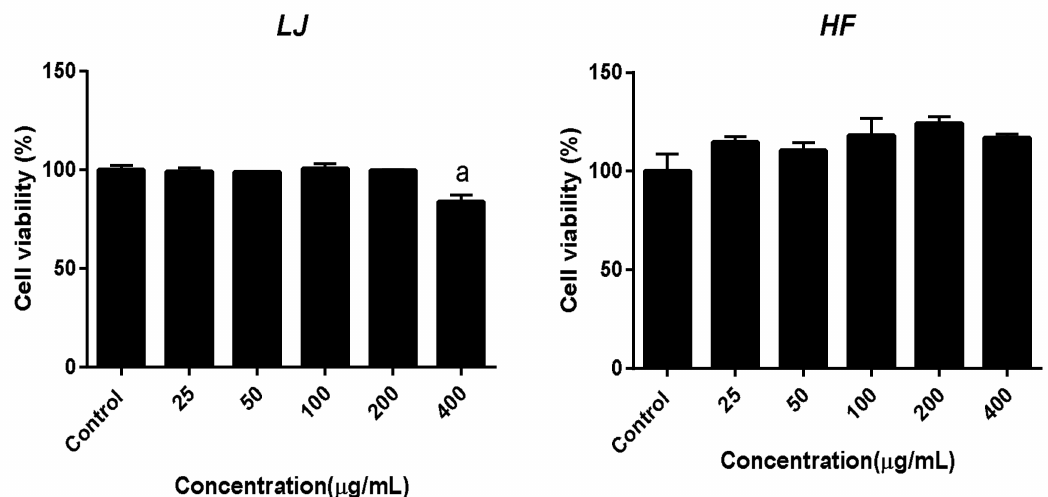
Figure 2. Effects of LJ and HF extracts on cell viability in C2C12 muscle cells. Data are represented as add the mean ± SEM of three independent experiments. a : Values that do not share the same superscript are significantly different by ANOVA ( p < 0.05).